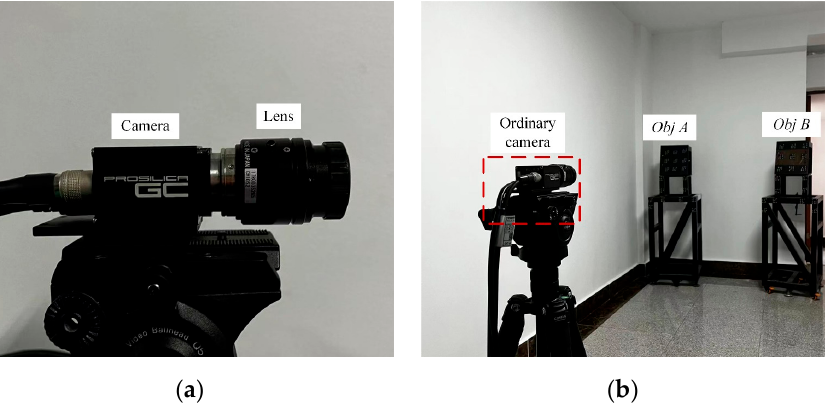
Figure 20. Pose estimation experiment using a single ordinary camera. ( a ) The ordinary camera system hardware setup in the experiment. ( b ) Scene of the pose estimation experiment using a single camera.